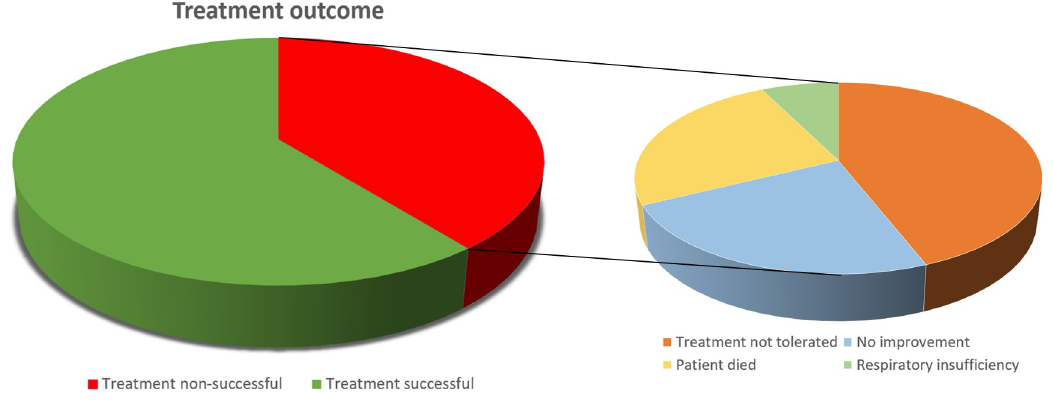
Fig 3. Treatment outcome of